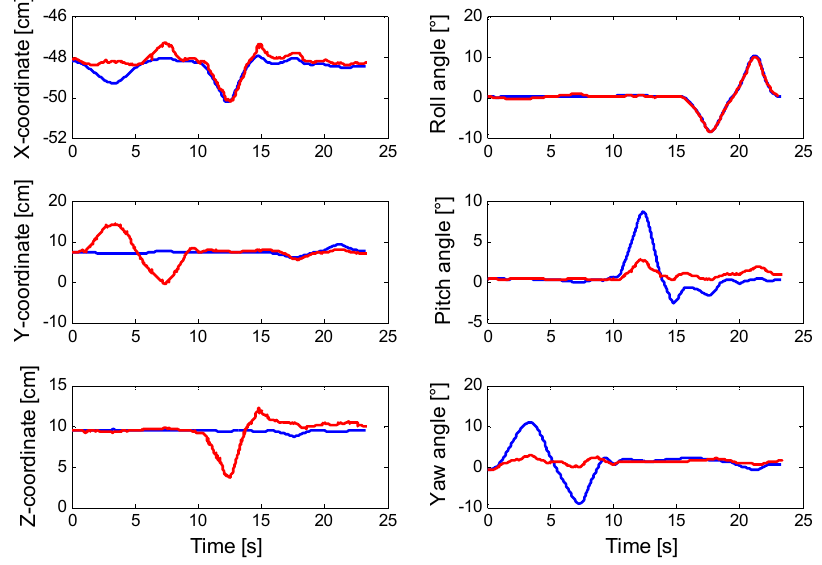
Figure 6. Reference and filtered position and Euler angles that are produced using the error-driven EKF (pure vision). Reference data in blue; filtered data in red.